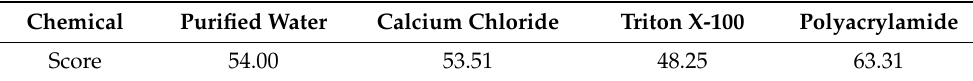
Figure 8. The statistical figure of standard values of several chemical materials for dust suppression. Table 4. Comprehensive evaluation score of dust suppressant performance of several chemical